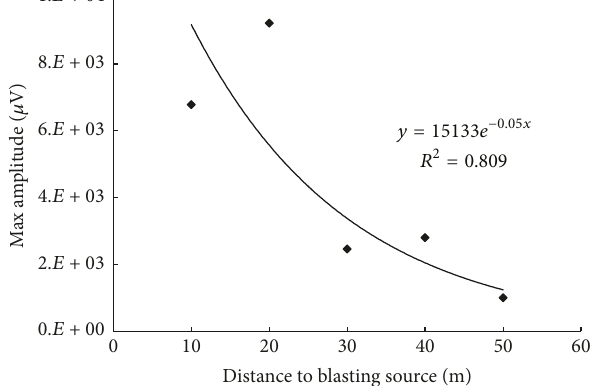
Figure 16: Relationship between vibration signal level amplitude and distance to blasting